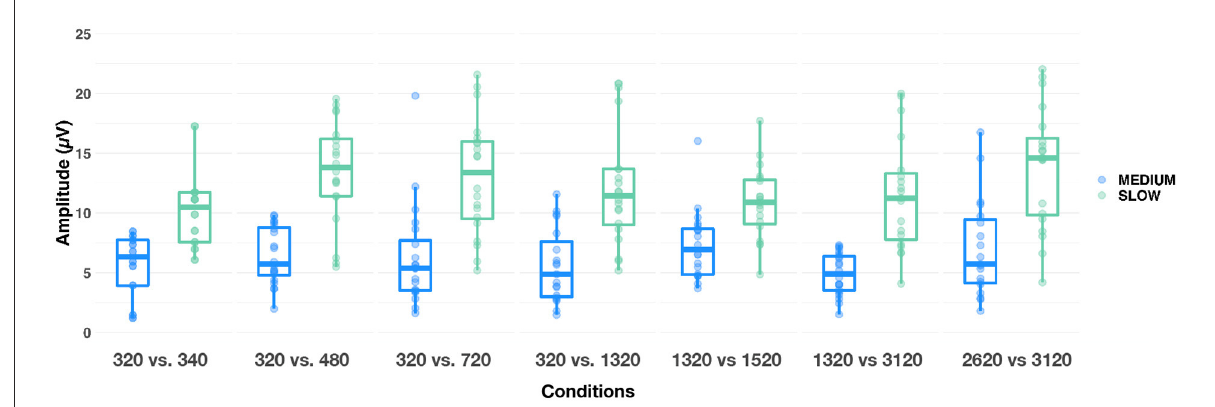
FIGURE7 Boxplots showing N1-P2 amplitude responses evoked in each condition, at medium (blue) and slow (green) alternating rates. The whiskers indicate values that fall within 1.5 times the interquartile range. Dots falling outside the whiskers are